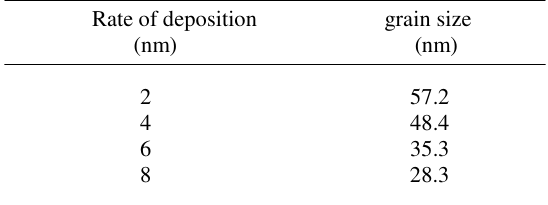
Table 3. Grain size of various films deposited at various